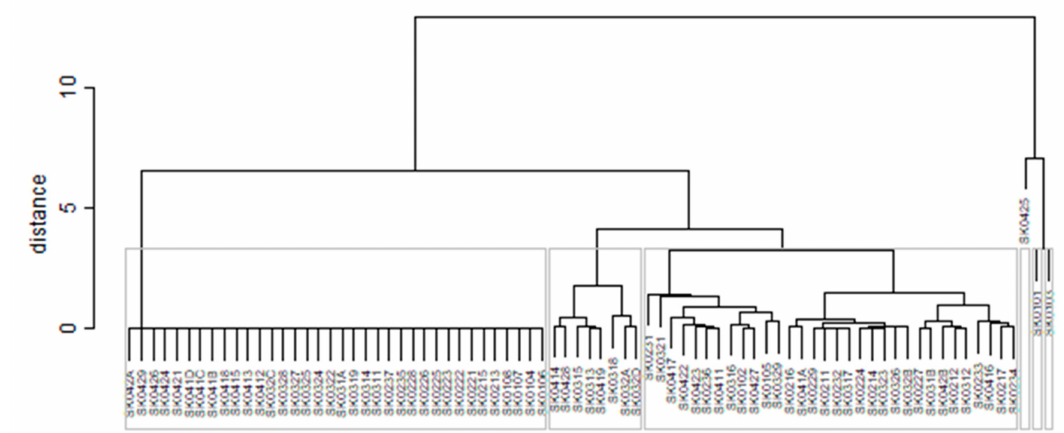
Figure 1. Medical equipment dendrogram of the districts in the year 2008. Source: own elaboration by the